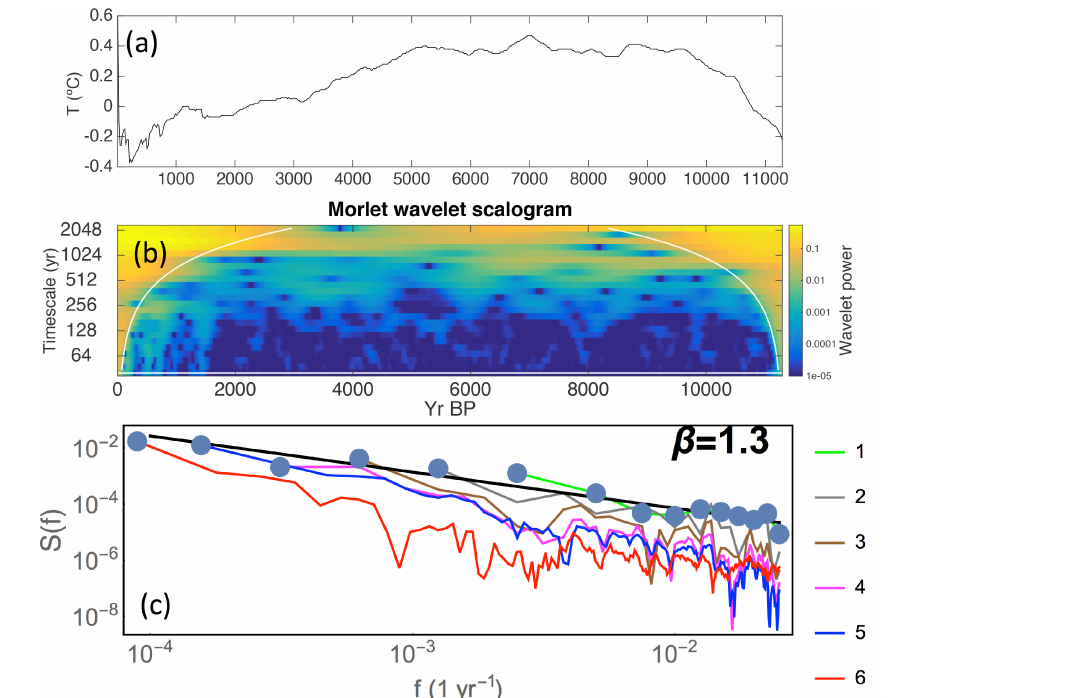
Figure 9. (a) The reconstructed time series covering the entire Holocene time period. (b) Wavelet scalogram for the same time period. (c) Section 1–6 of the reconstruction described in Sect. 5.2, and composite spectrum (black line, blue dots). The estimated β is estimated for this